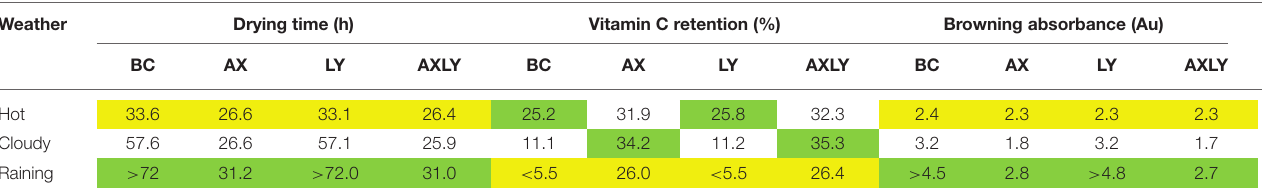
TABLE 4 | Drying time, vitamin C, and browning reaction for different solar drying improvement strategies* and weather conditions. Weather Drying time (h) Vitamin C retention (%) Browning absorbance (Au) BC AX LY AXLY BC AX LY AXLY BC AX LY AXLY Hot 33.6 Cloudy Raining > 72 31.2 >